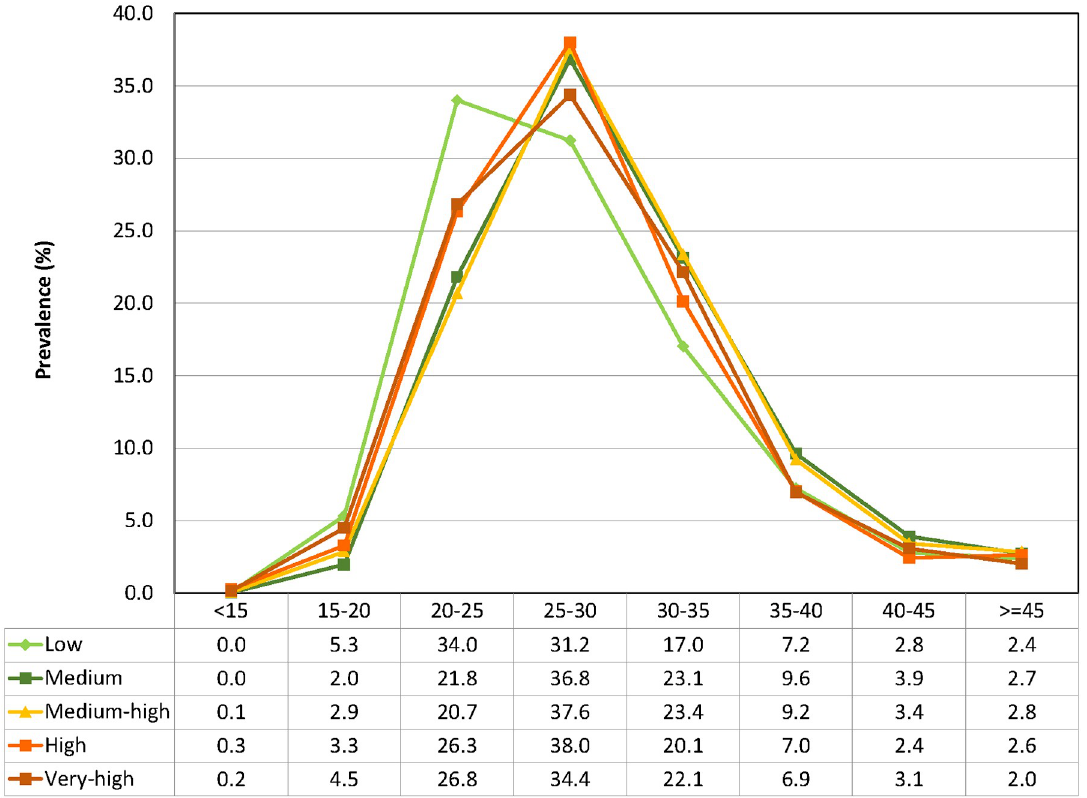
Fig 1. Distribution of the prevalence (%) of the eight BMI categories among the five mortality risk groups: Low, medium, medium- high, high and very-high risk. https://doi.org/10.1371/journal.pone.0253696.g001 0.222 and 0.514 respectively. However, in the Medium-high risk group the mortality rate for the BMI of 25 to < 30, 30 to < 35 and 35 to < 40 was 0.222, 0.226 and 0.239 respectively. These findings are better appreciated in Fig 2 where each risk group and the entire cohort are represented as their unadjusted mortality risk and 95% confidence interval, using BMI as a continuous variable. The mortality risk increases significantly between the risk groups, with relatively small changes attributable to changes in BMI, except for very low and very high BMI. Table 2. Raw 8-year mortality rates in the entire cohort and the risk groups by BMI categories.